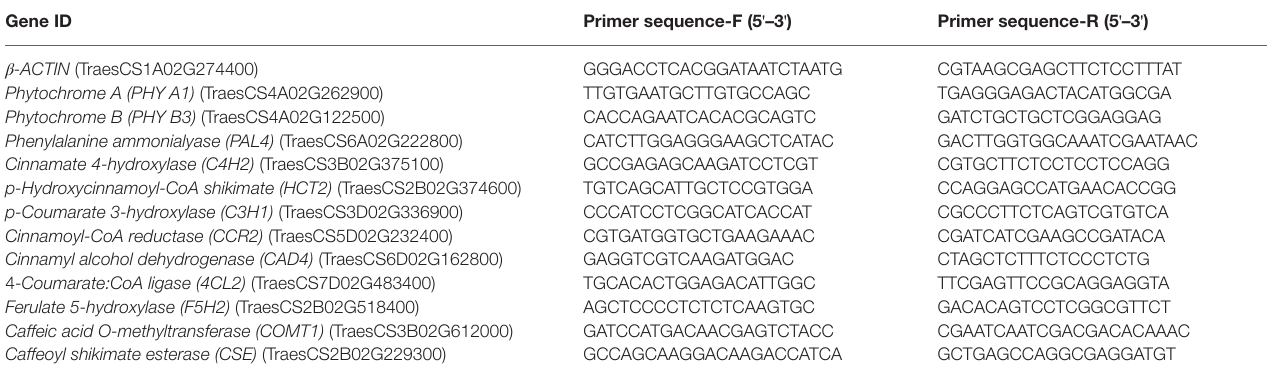
TABLE 1 | Sequence of primers and probes for TaPhy A , TaPhy B , and key genes in the lignin biosynthesis pathway. Gene